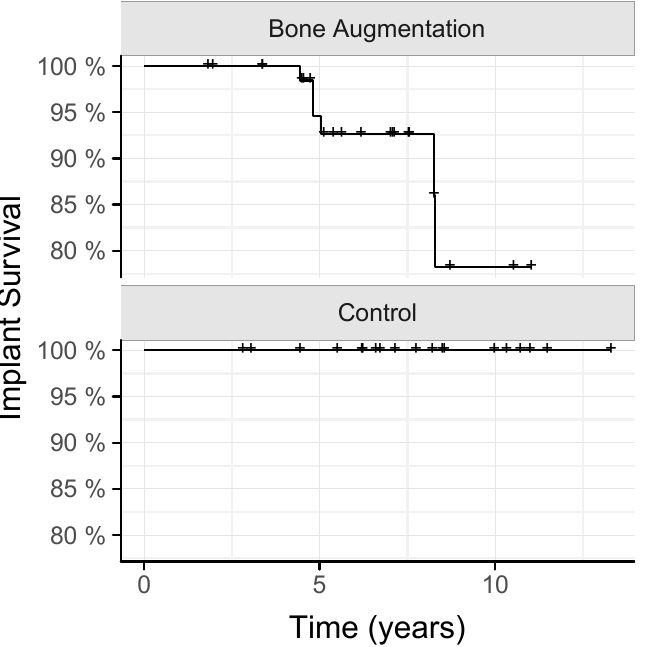
Figure 3. Kaplan–Meier survival curve of implants placed in iliac crest augmentations and pristine bone (control).